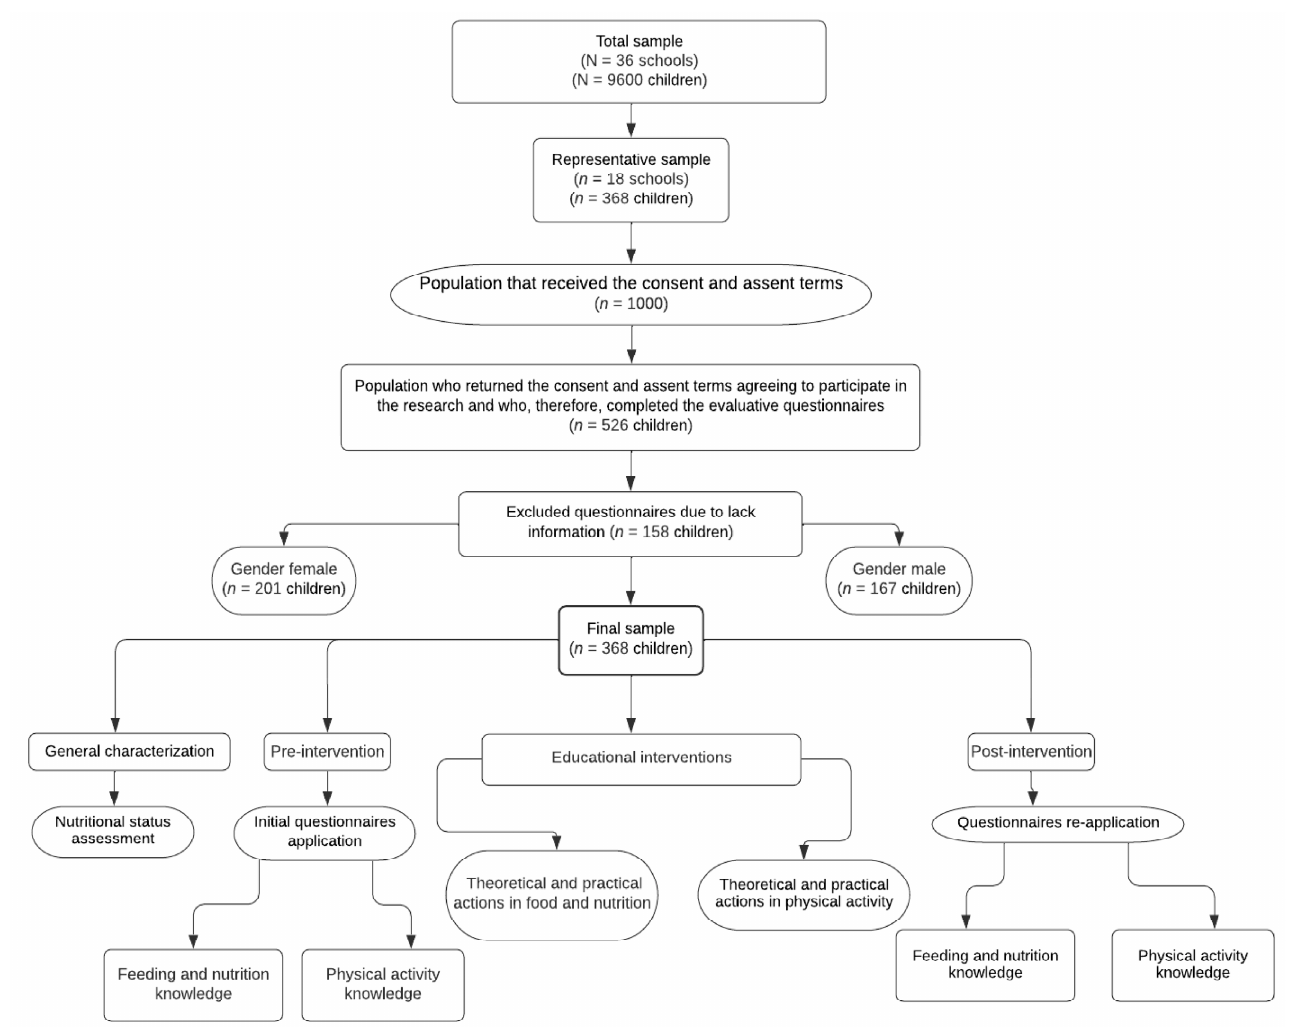
Figure 1. Research steps flowchart carried out with school-aged